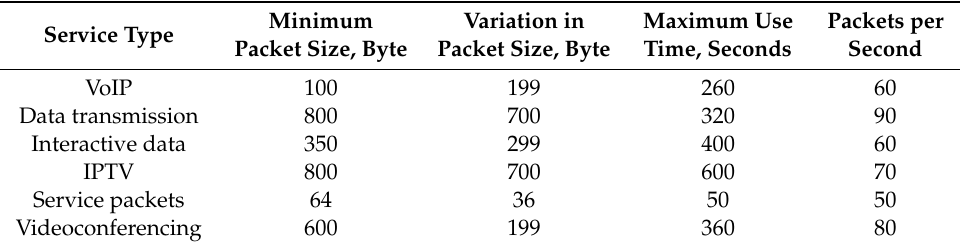
Table 3. E-service